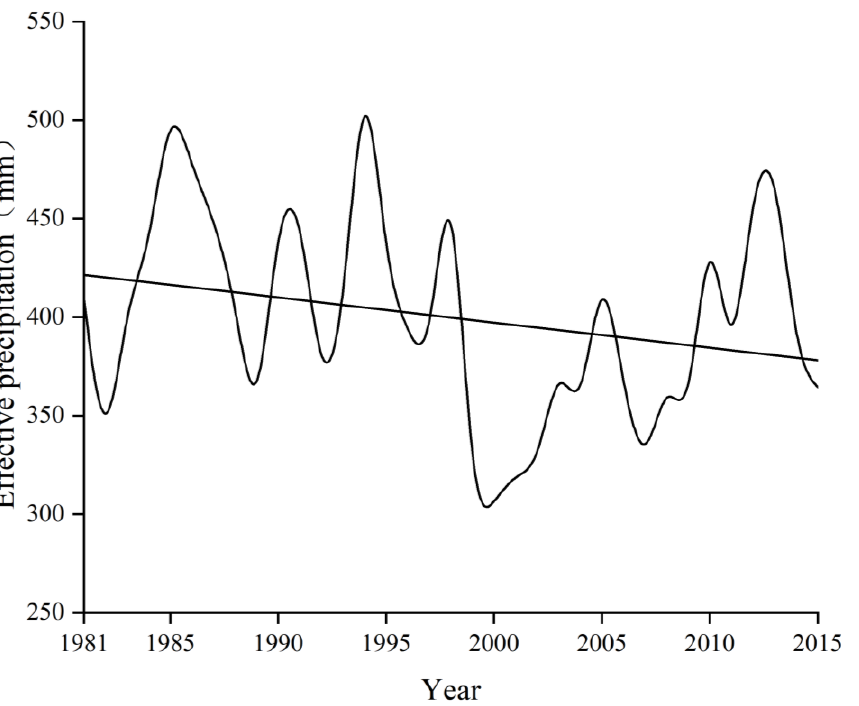
Figure 2. Effective precipitation trend during the growing season of maize in Northeast China, 1981– 2015.